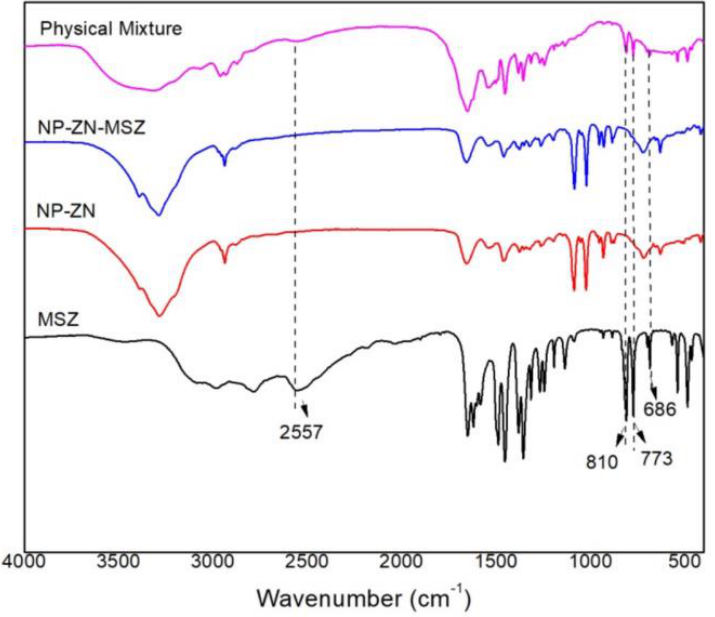
Figure 6. FTIR spectrum (KBr pellet) of the physical mixture of zein nanoparticles with and without the drug.